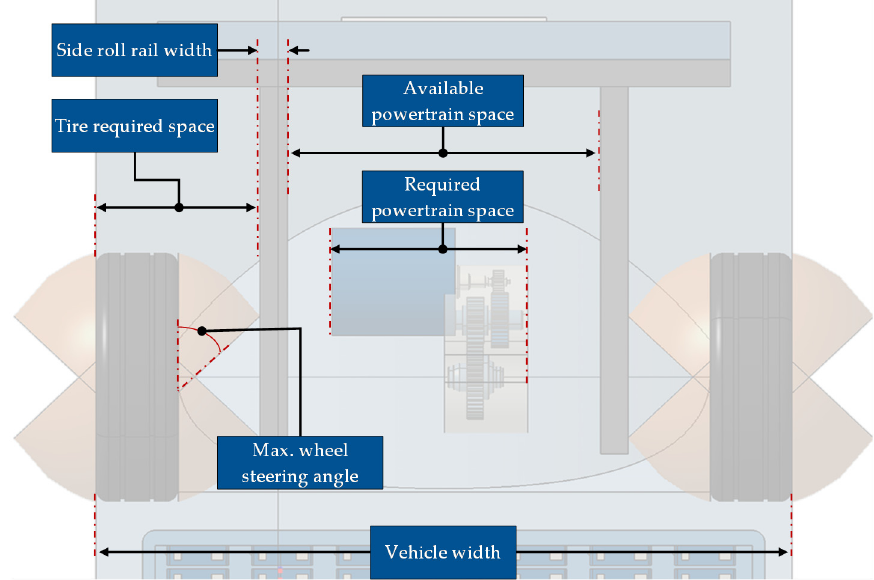
Figure 7. Overview of a dimensional chain at the front-end compartment.